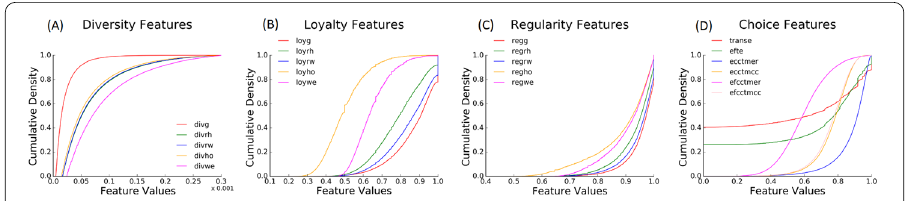
Figure 1 Cumulative density functions of the STC features. Cumulative density functions of each feature belonging to each behavioral trait is shown and grouped together in a single graph. For better readability, names of features are abbreviated as explained in Features